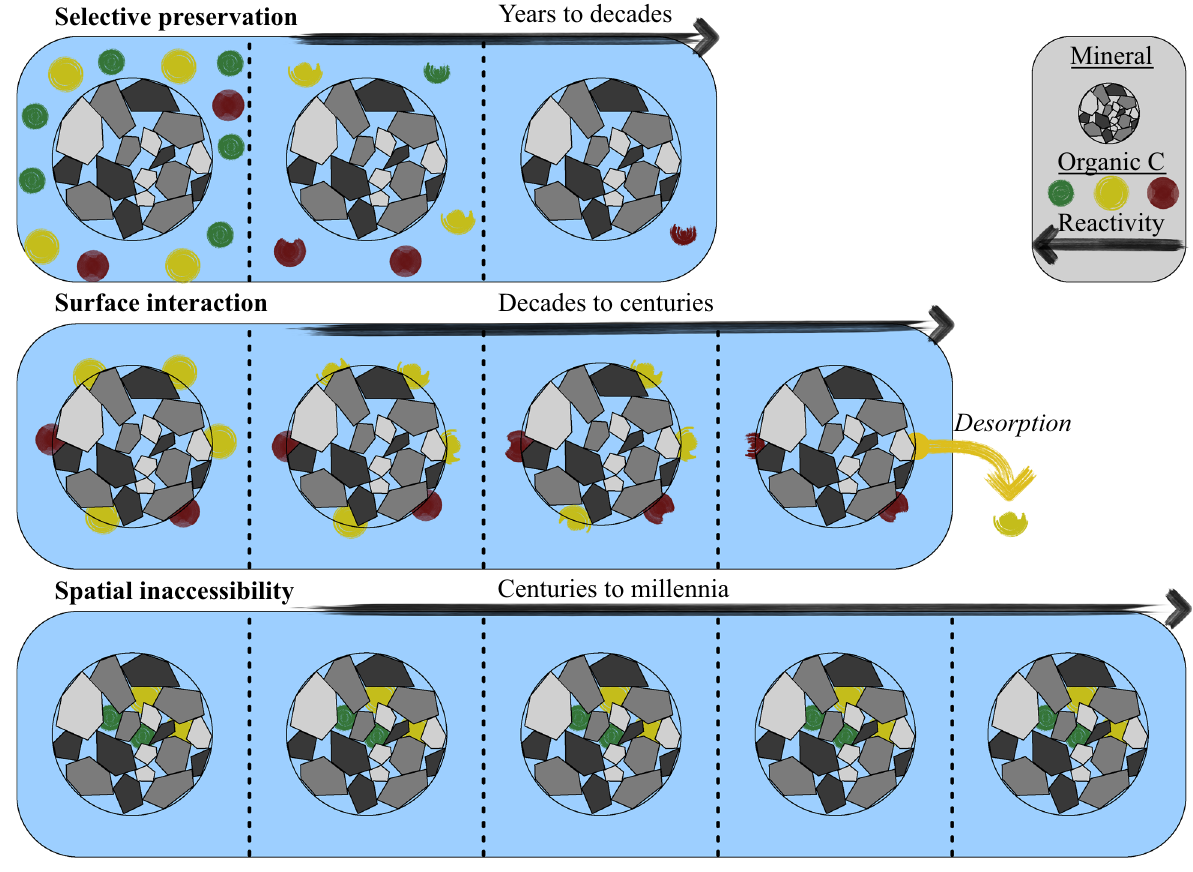
Figure 1. A conceptual overview of three different C preservation processes in mineral